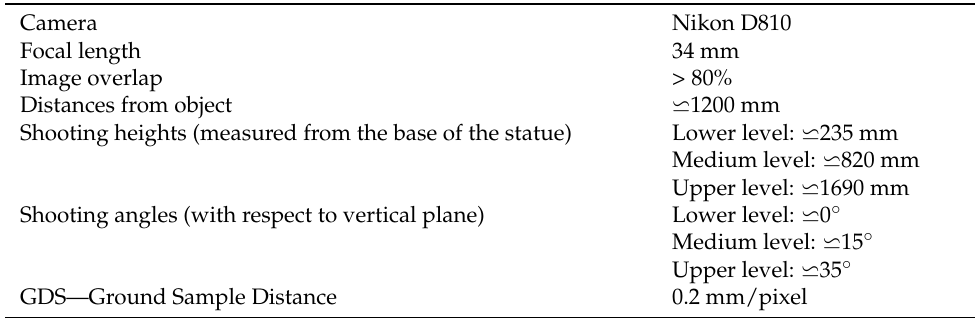
Table 2 resumes the parameters of the photogrammetric acquisition; average values of the heights and angles of acquisition are reported. Table 2. Summary of photogrammetric acquisition